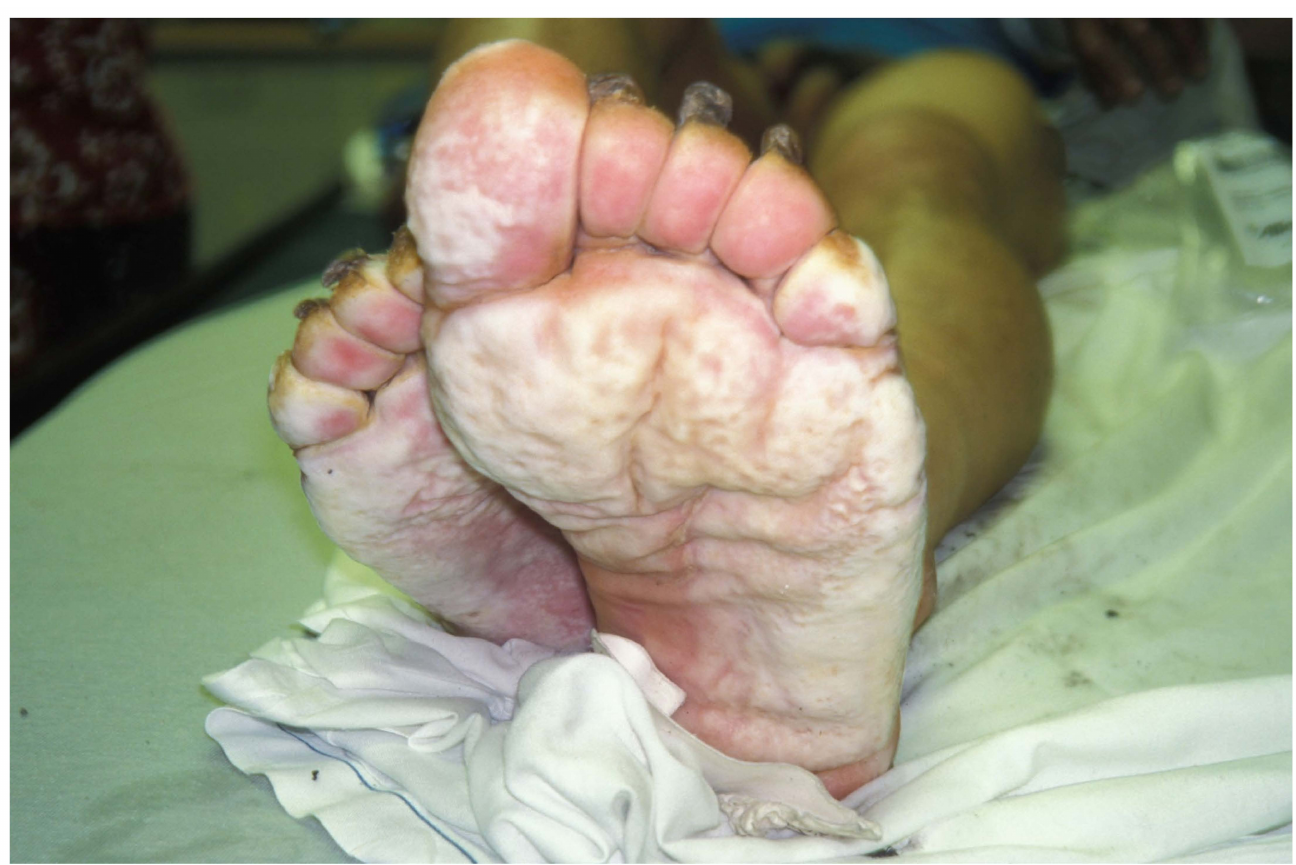
Figure 1. Nonfreezing cold injury (trench foot). Photo courtesy of Ken